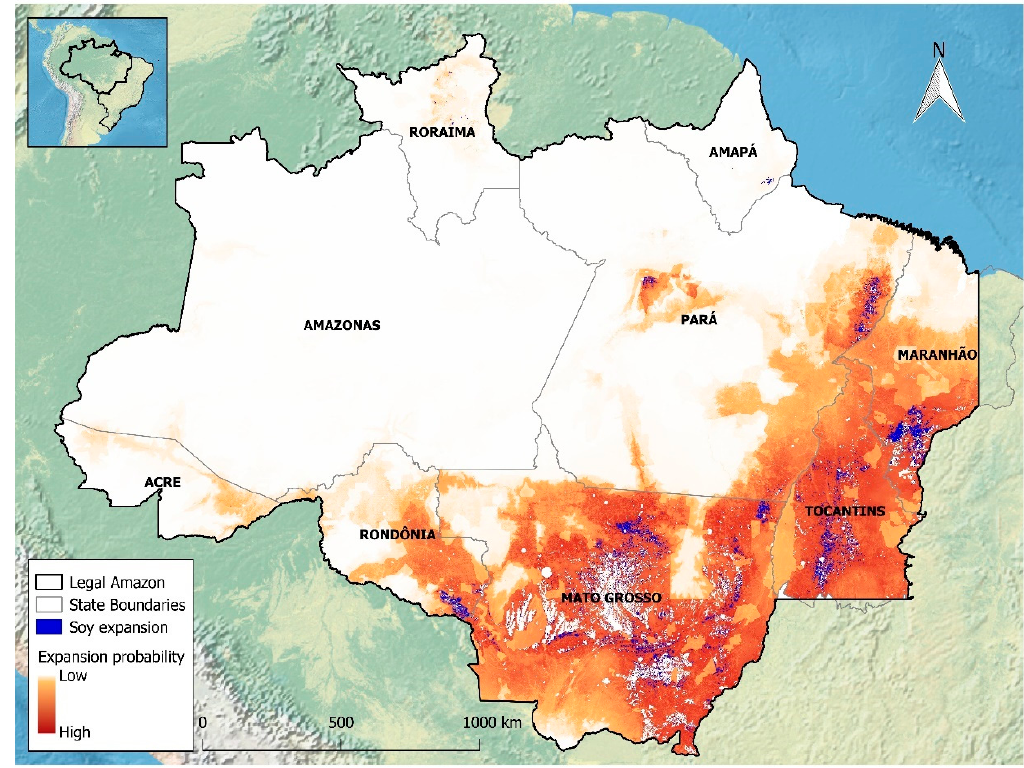
Figure 3. Probability of soy expansion in the Legal Amazon and forecasted soy expansion for 2020.